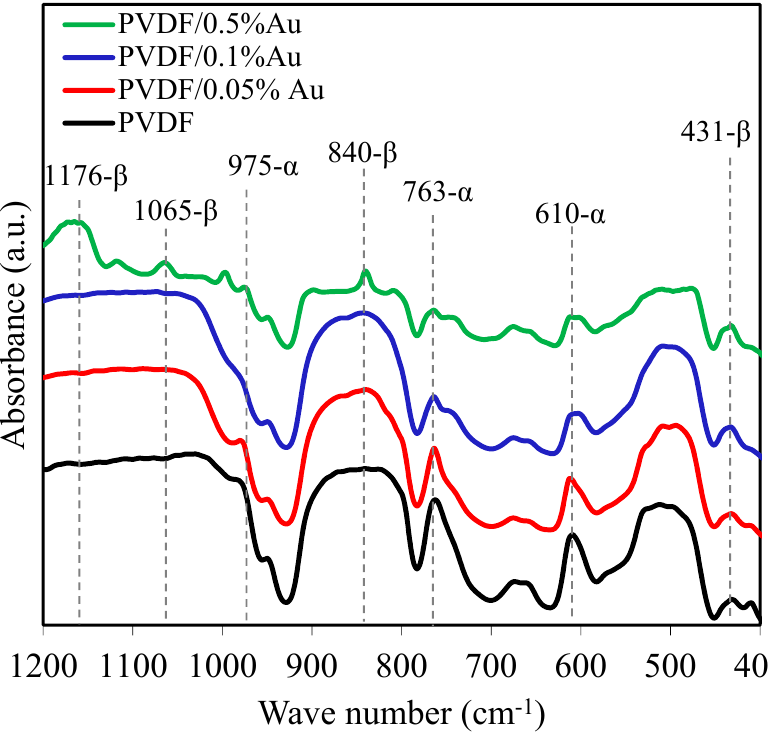
Figure 5. FTIR spectra of PVDF and PVDF/Au nanocomposite films.